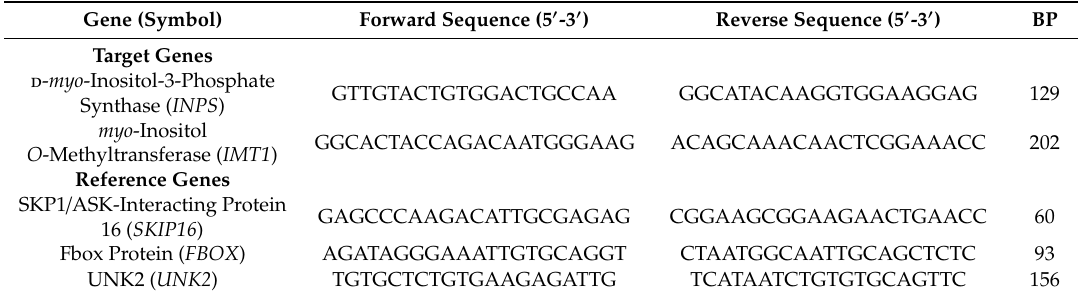
Table 2. Primers designed to isolate target genes involved in d -pinitol synthesis and reference genes used to normalize samples in soybean leaves and